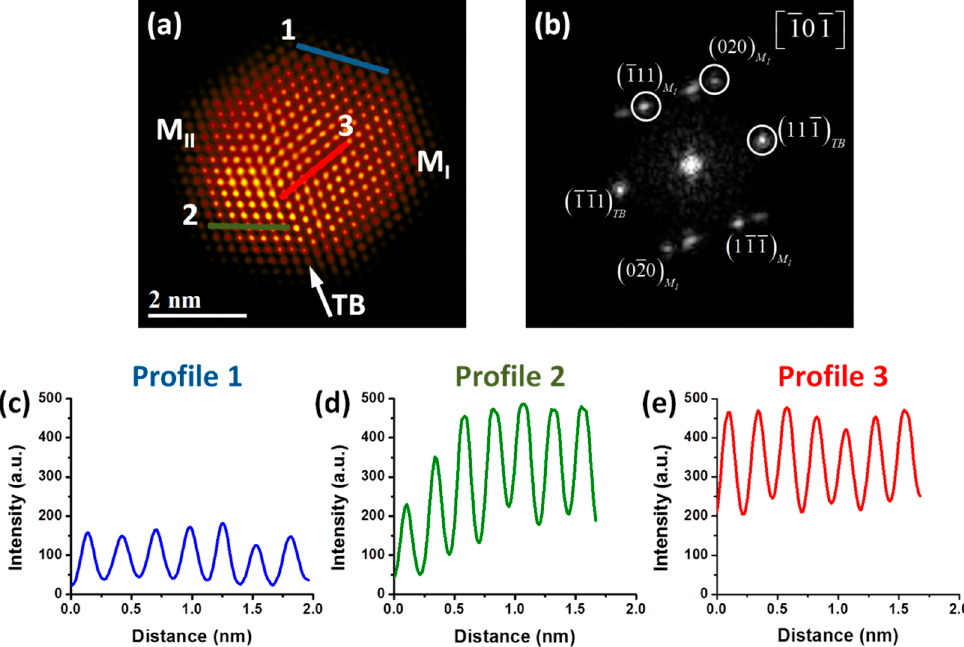
Figure 2. ( a ) High-angle annular dark-field scanning transmission electron microscopy (HAADF-STEM) image of a PdPt nanoparticle, ( b ) Fast Fourier transform (FFT) showing the twin boundary plane, and intensity profiles along ( c ) blue line, ( d ) green line and ( e ) red line, respectively.